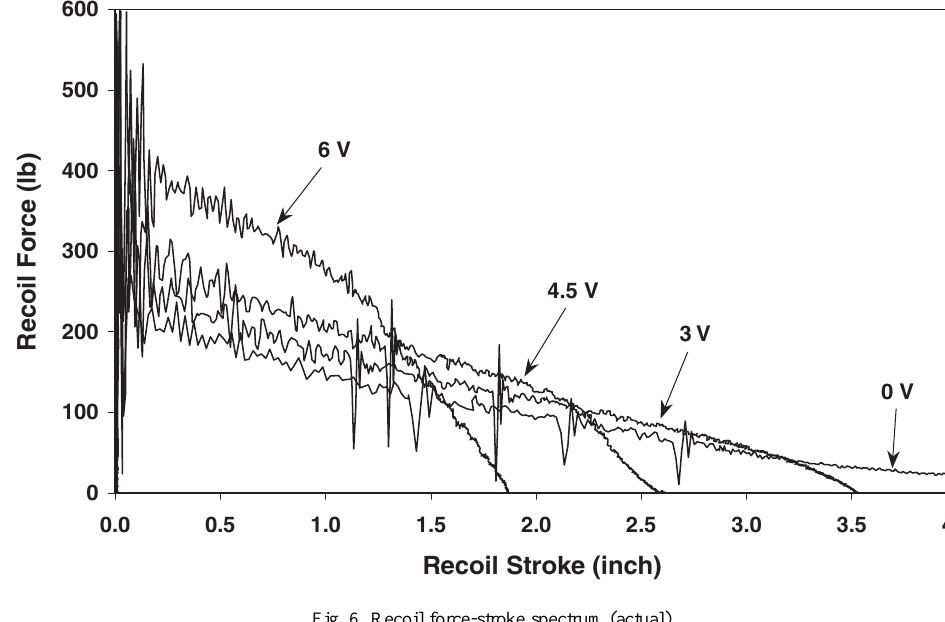
Fig. 6. Recoil force-stroke spectrum (actual).